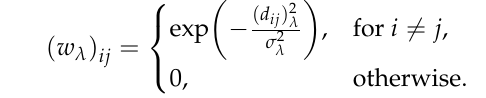
Figure 2. The distributions of the parking durations in the Queensberry area in Melbourne in each month of 2017. The size of parameter λ of the function can be used to measure the closeness of the relationship between two areas. The absolute value of the difference in two parameters (cid:1) | λ − λ | is denoted as (cid:0) d . We call this difference the “distribution distance”. Similarly i j ij λ to the weight matrix in Section 3.2, we can obtain another weight matrix based on the “distribution distance”. The weight based on the “distribution distance” of the i -th and j -th areas W λ is expressed